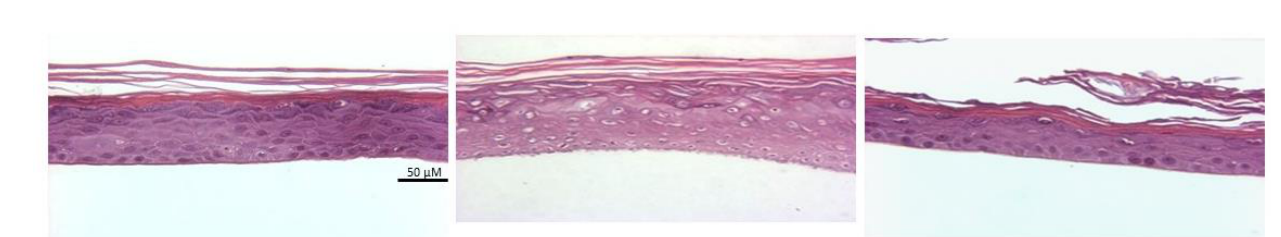
Figure 2. Histological evaluation of EpiDerm constructs. A fresh construct ( left ) was compared with a 15% glycerol – 10% HES frozen construct ( middle ) and a VS55 vitrified construct ( right ). H&E-stained sections at 40×.